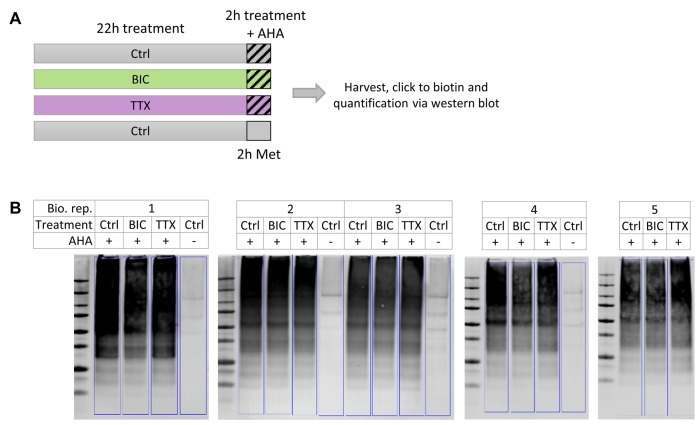
Quantification of nascent proteins via western blot.(A) Primary hippocampal cultures were treated with BIC, TTX or vehicle (Ctrl) for 24 hr. During the last 2 hr, newly synthesized proteins were labeled with AHA (4 mM). A negative control sample was treated with methionine (Met; 4 mM) instead of AHA. AHA-labeled proteins were covalently bound to biotin via a click reaction and quantified by western blot. (B) Western blots against biotin-tagged nascent proteins.